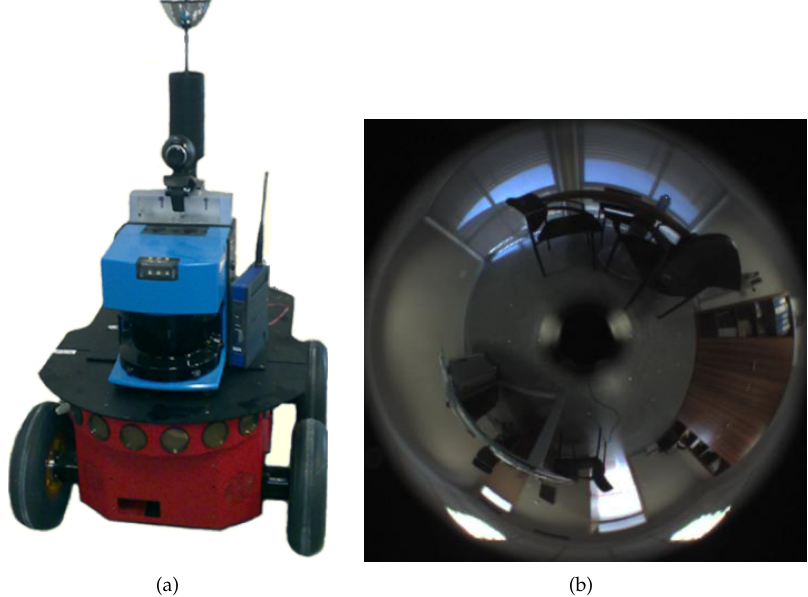
Figure 1. ( a ) Example of a robot Pioneer P3-AT R (cid:13) equipped with an omnidirectional vision system and a laser range finder. In this work, only the omnidirectional camera is used. ( b ) Example of an omnidirectional image captured from one